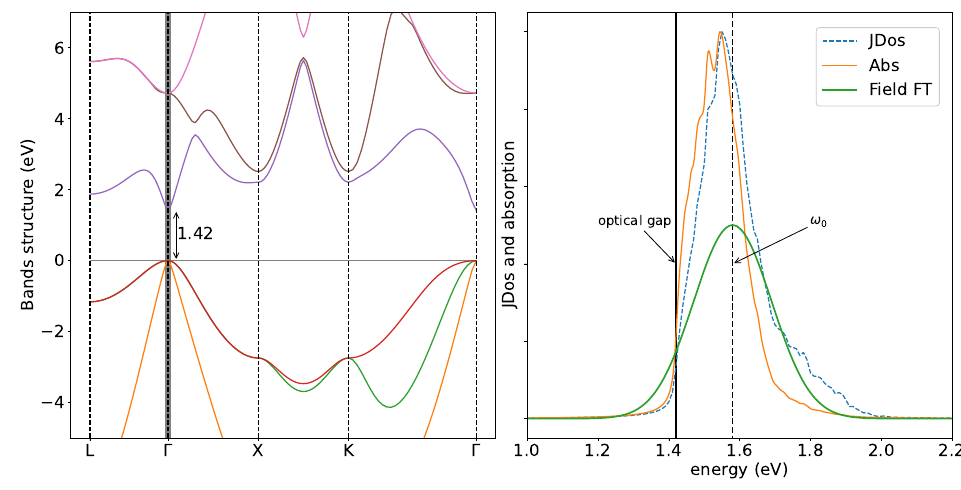
Figure 1: (Left) Quasi-particle band structure of GaAs. The grey thick line represents the size of the optical active region K , where an ultra fine sampling of the BZ is pump performed. (Right) Absorption spectrum and JDos of the optical transitions in the K region. The green line shows the energy profile of the pump